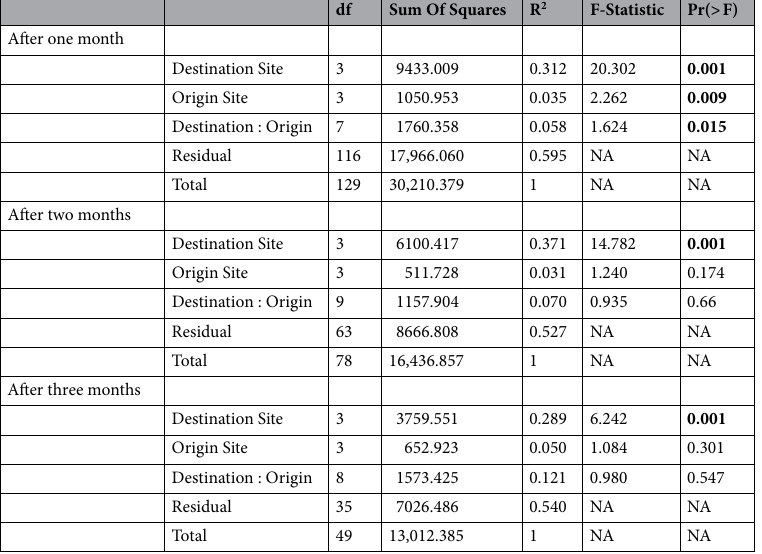
df Sum Of Squares R 2 F-Statistic Pr(> F)